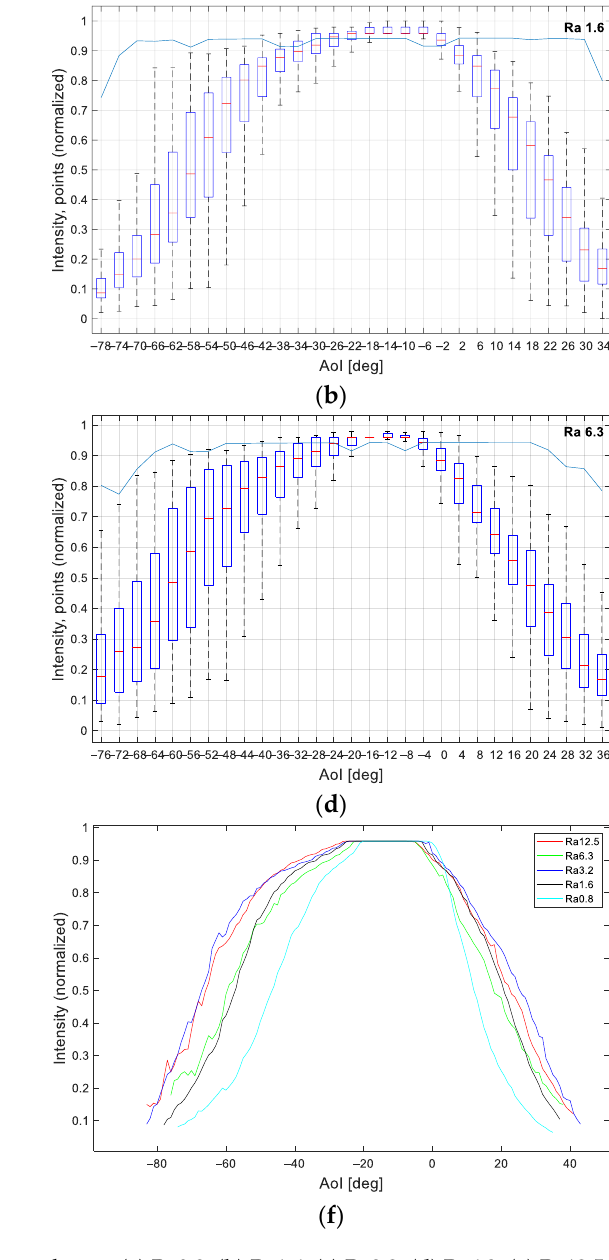
Figure 12. Processed intensity of aluminum alloy of different roughness: ( a ) Ra0.8; ( b ) Ra1.6; ( c ) Ra3.2; ( d ) Ra6.3; ( e ) Ra12.5; ( f ) median values in each measured position for all aluminum samples.